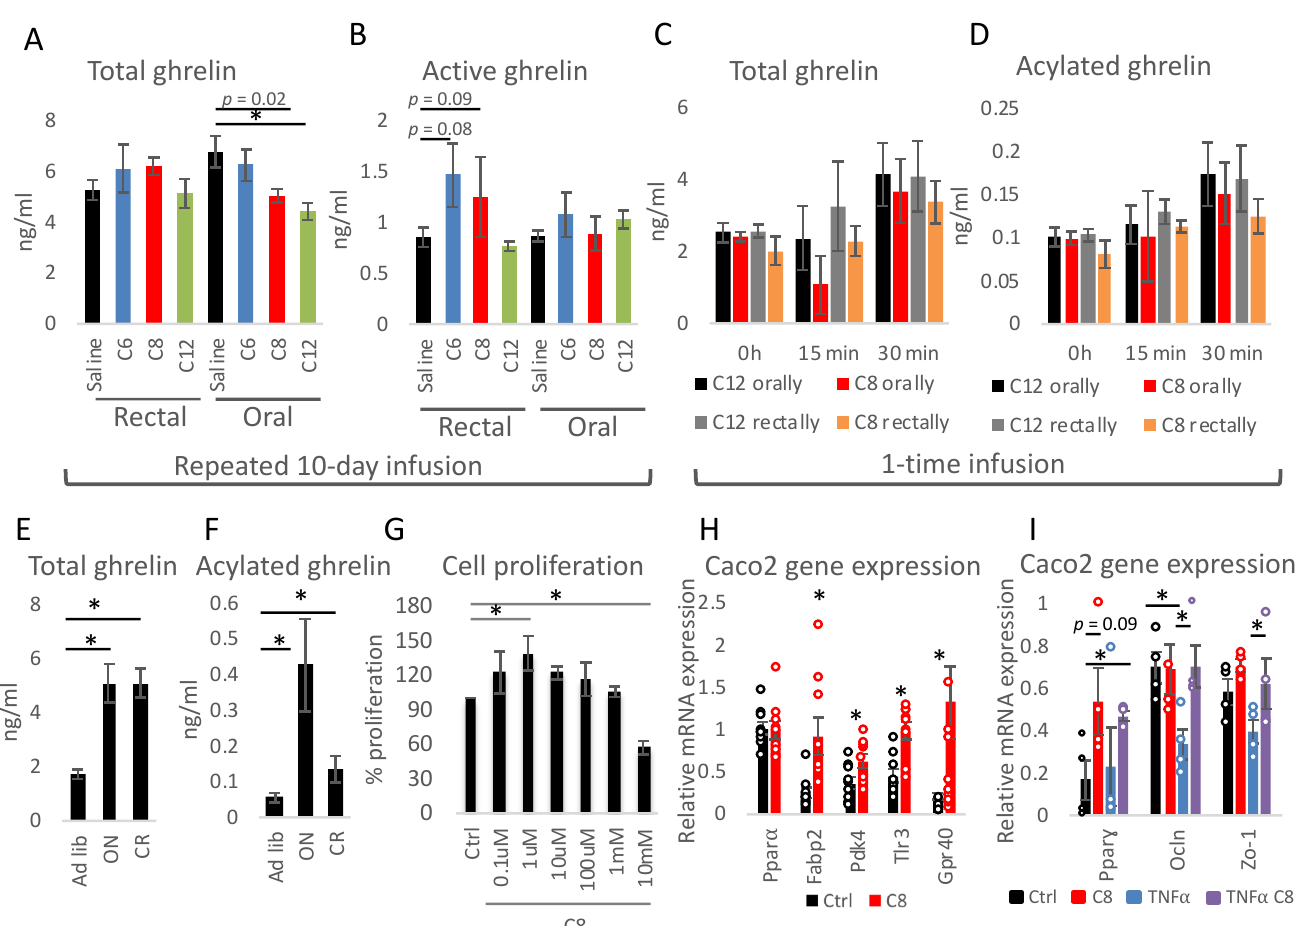
Figure 4. Caprylate affects Caco-2 cell proliferation and gene expression. Total ( A , C , E ) and active ( B , D , F ) ghrelin were measured in plasma of mice submitted to 10-day infusion of FAs ( A , B ), one-time infusion of caprylate and laurate ( C , D ), as well as to ON fasting and CR ( E , F ). Caco-2 cell proliferation was measured following control and caprylate treatment for 4 h using a BrdU assay ( G ). Gene expression was measured in Caco-2 cells following caprylate ( H ) or caprylate and TNF α ( I ) treatment. The groups in panels ( A – D , G , I ) were compared using ANOVA with Bonferroni correction for multiple testing. Student’s t -test was applied to assess statistical differences between the groups in panels ( E , F ) and H; n = 8 for ( A , F ), n = 6 for ( G ), n = 9 for ( H ); n = 4 for ( I ); * p < 0.05. Data are presented as mean ± SEM. Circles in panels H and I indicate values for each biological replicate in the experimental